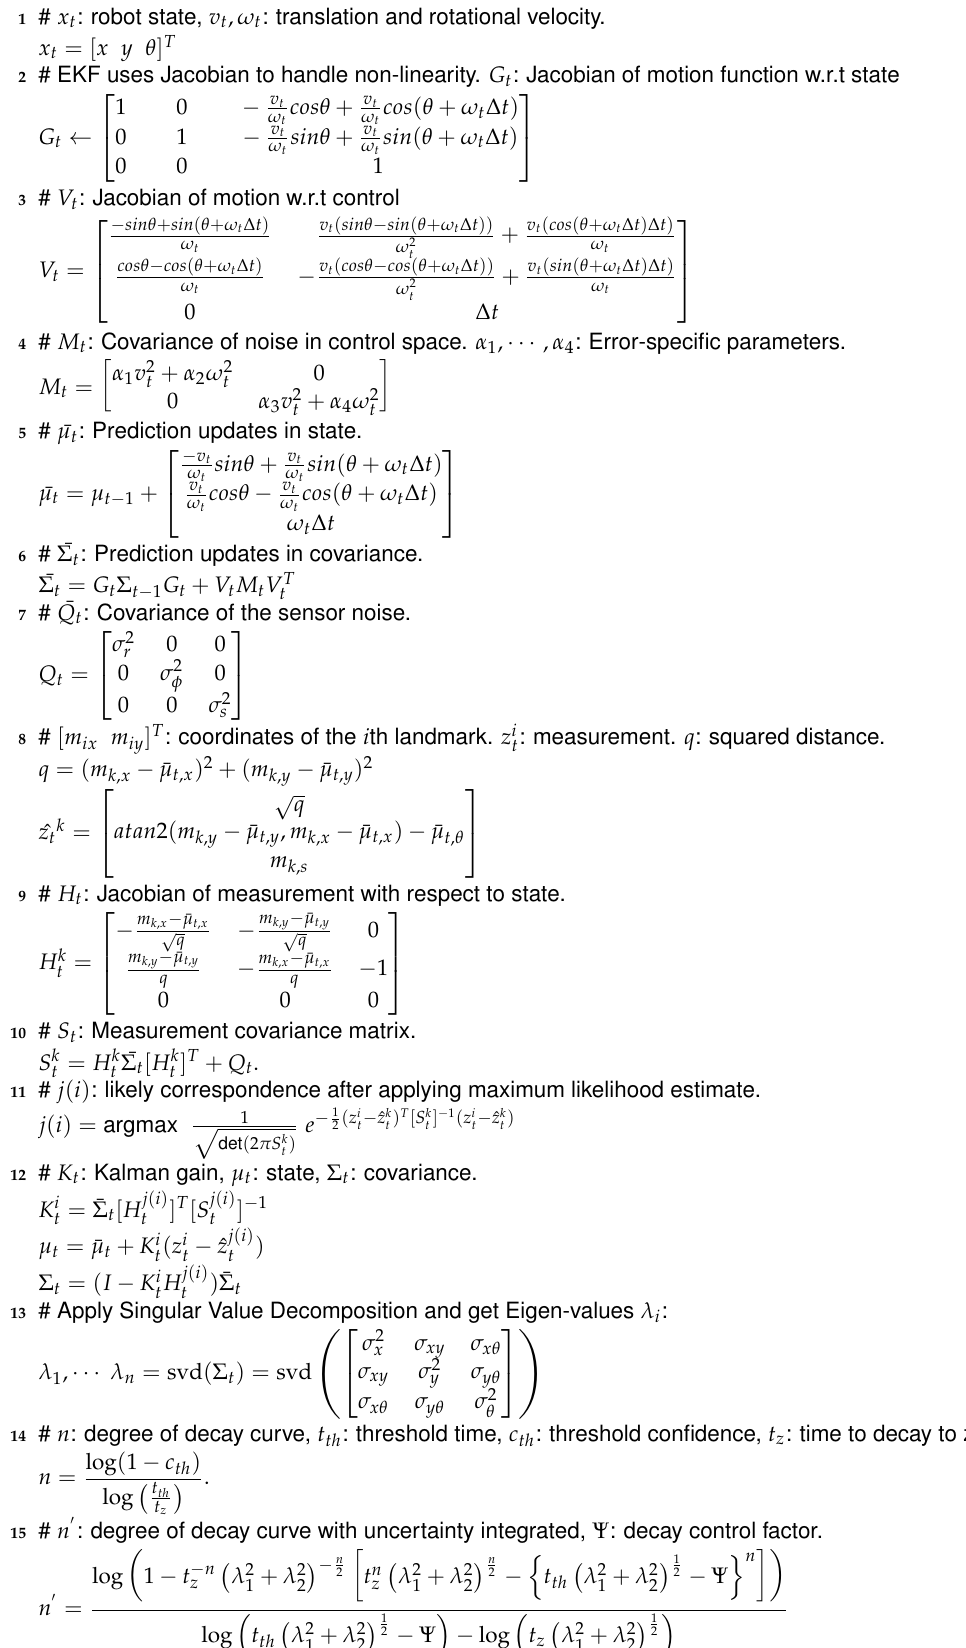
Algorithm 2: Uncertainty Integrated Confidence Decay with Extended Kalman